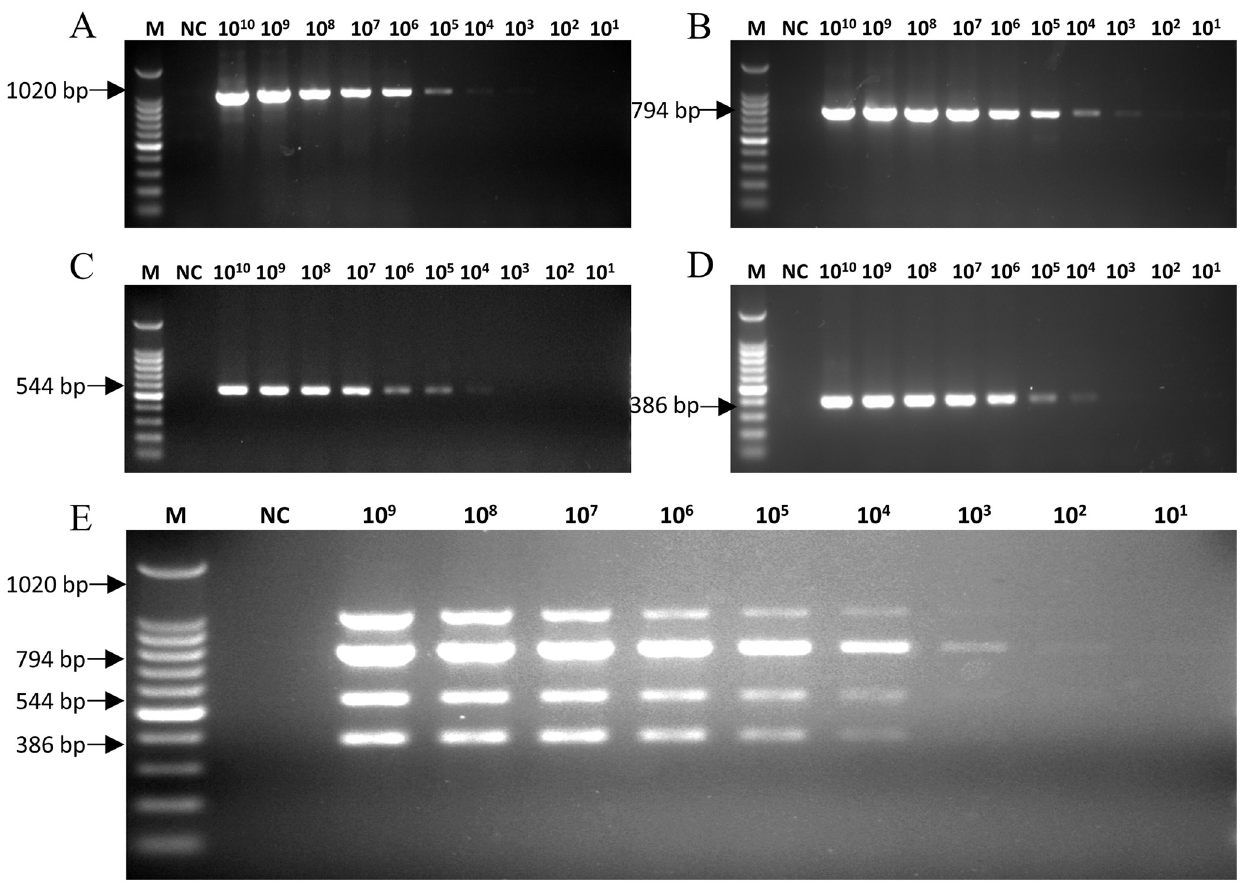
Fig 3. Sensitivity of the mPCR method for CRV detection. The four single plasmids (pMD-CAV-2, pMD-CDV, pMD-CIV and pMD-CPIV), diluted from 1 × 10 10 to 1 × 10 1 copies/ μ l, and the mixed plasmids (pMD-CAV-2/pMD-CDV/pMD-CIV/pMD-CPIV), diluted from 1 × 10 9 to 1 × 10 1 copies/ μ l, were used to determine the minimum detection limit of the CRV mPCR method. (A) The sensitivity of pMD-CAV-2; (B) the sensitivity of pMD-CDV; (C) the sensitivity of pMD-CIV; (D) the sensitivity of pMD-CPIV; (E) the sensitivity of pMD-CAV-2/pMD-CDV/pMD-CIV/pMD-CPIV; Lane M, 100 bp DNA ladder; Lane NC, negative